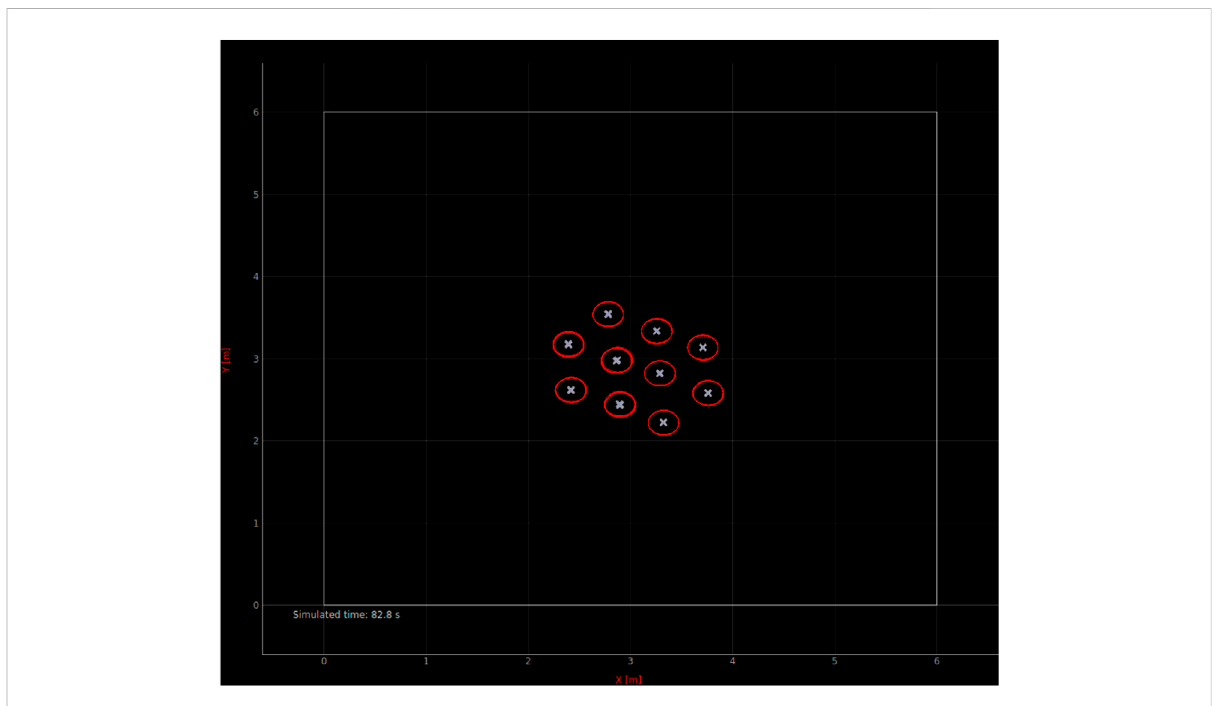
FIGURE 3 Screenshot of our custom spatial microscopic simulator implementing our μ M-A.